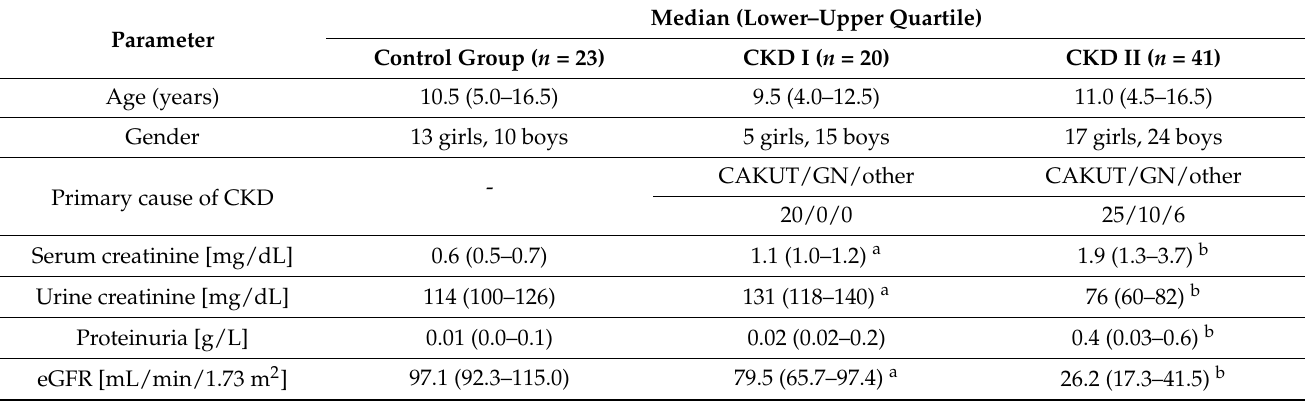
Table 1. Basic clinical characteristics of the patients.